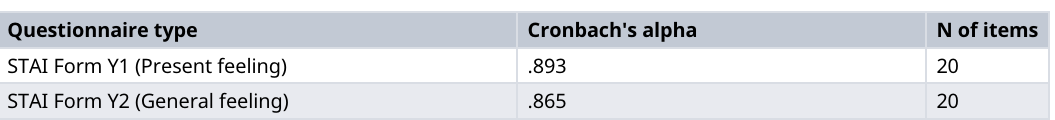
Table 4. Cronbach alpha reliability